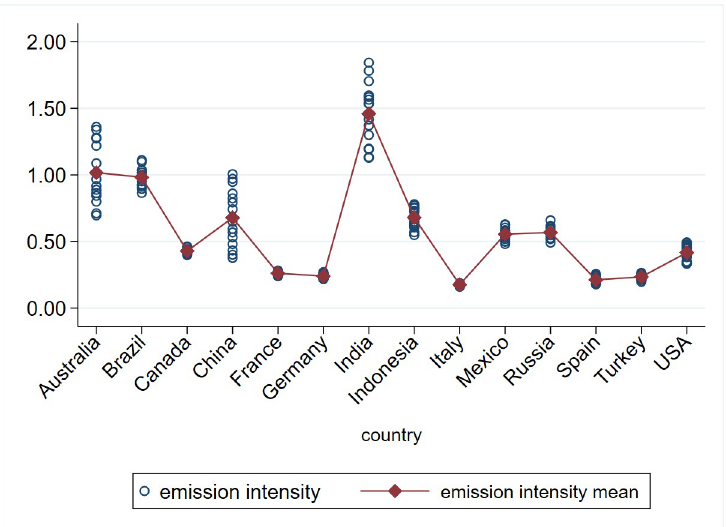
Fig 4. Heterogeneity of emission intensity across countries. Source: Authors’ calculations (in STATA 15) based on data from WIOD Environmental Accounts (Update 2000–2016), WIOD, Release 2016 and FAO Emissions Database.